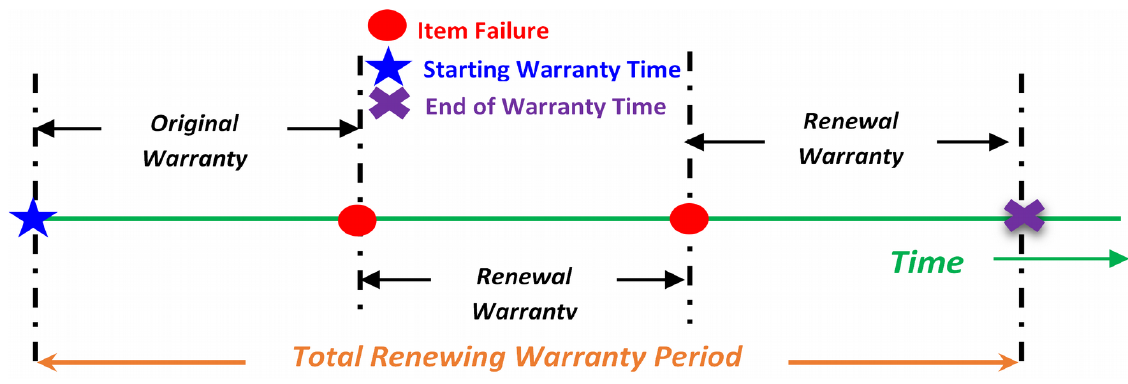
Figure 4. Parameters used in the ARTO